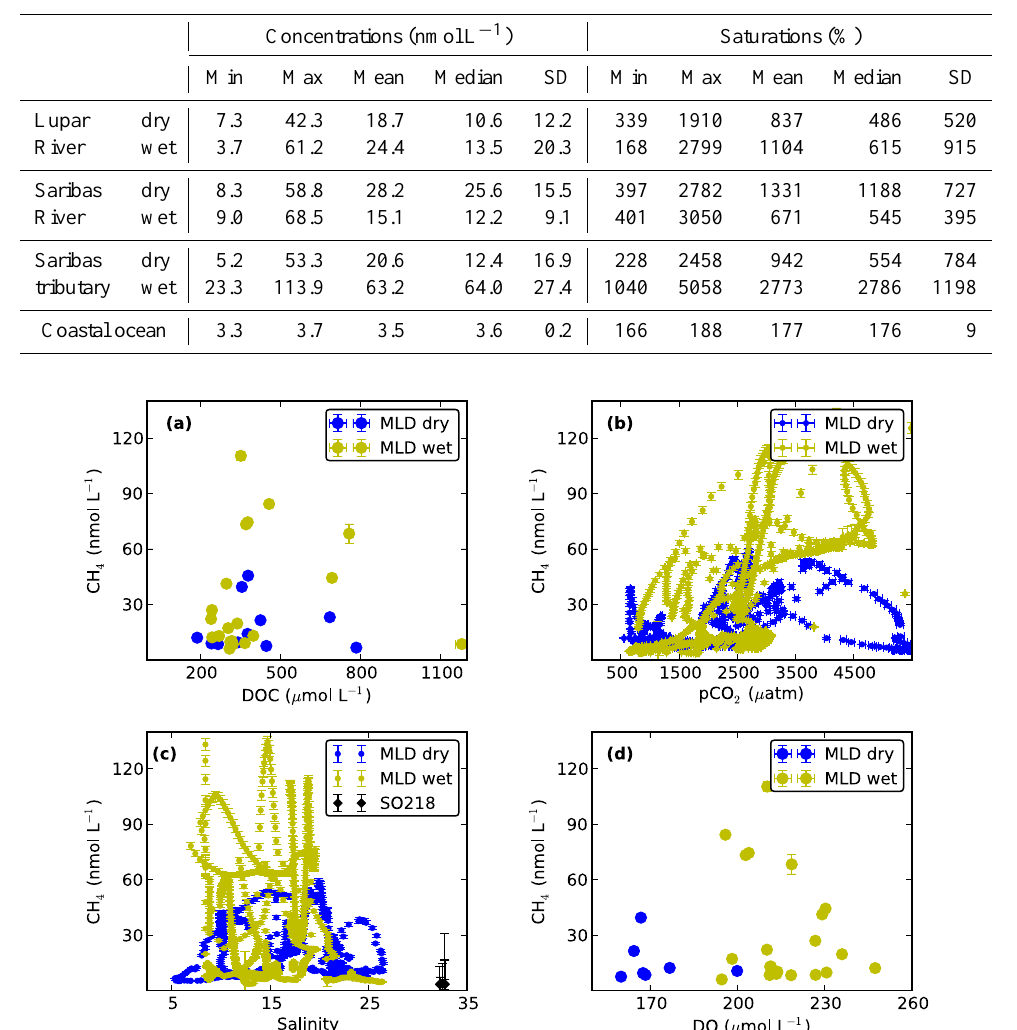
Figure 5. Relationship of methane concentrations with (a) dissolved organic carbon (DOC), (b) p CO 2 , (c) salinity, and (d) dissolved oxygen (DO). MLD refers to the campaigns on the Lupar and Saribas estuaries in the dry and wet season, respectively; SO218 denotes data from the R/V Sonne